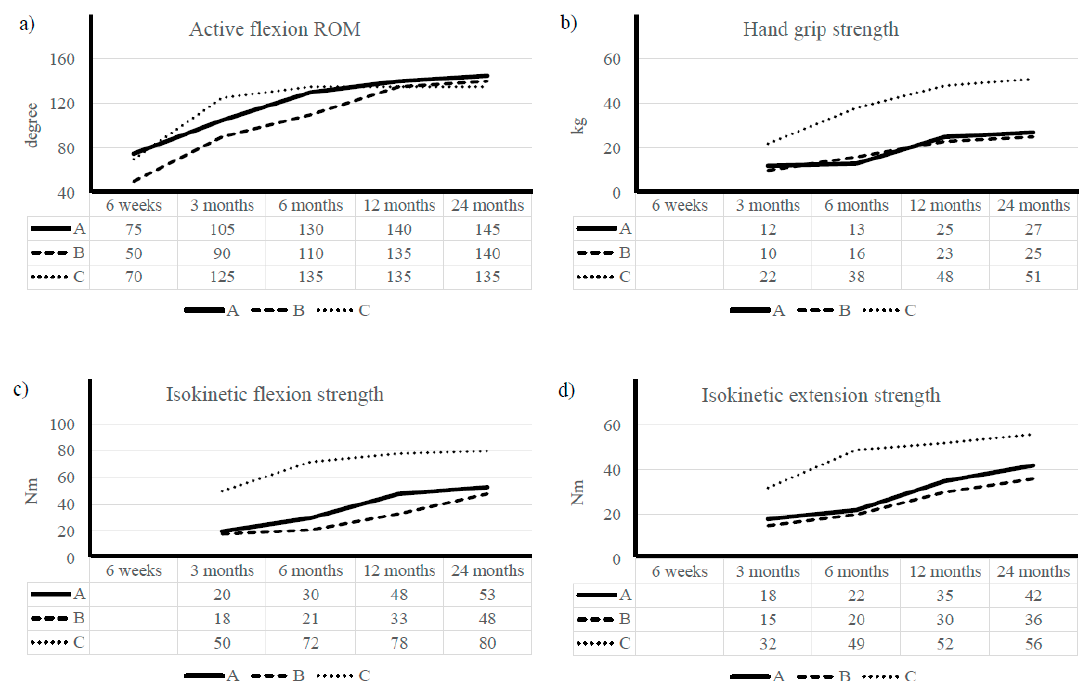
Figure 3. Results of ROM and strength. ROM, range of motion; Nm, newton meter. ( a ) Healthy side